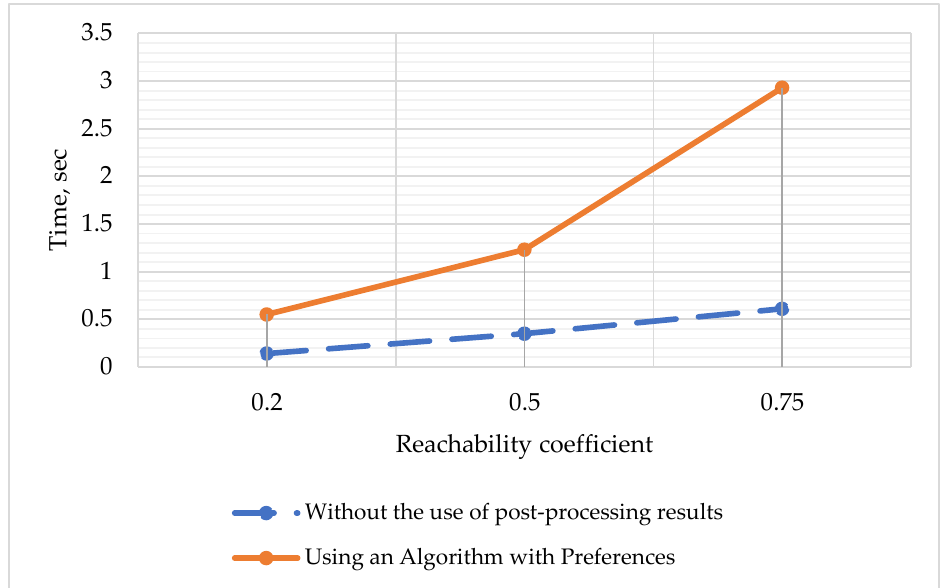
Figure 12 . Comparative analysis of the modified version of the Bellman – Ford algorithm without Figure 12. Comparative analysis of the modified version of the Bellman–Ford algorithm without post-processing of results and with it. post-processing of results and with